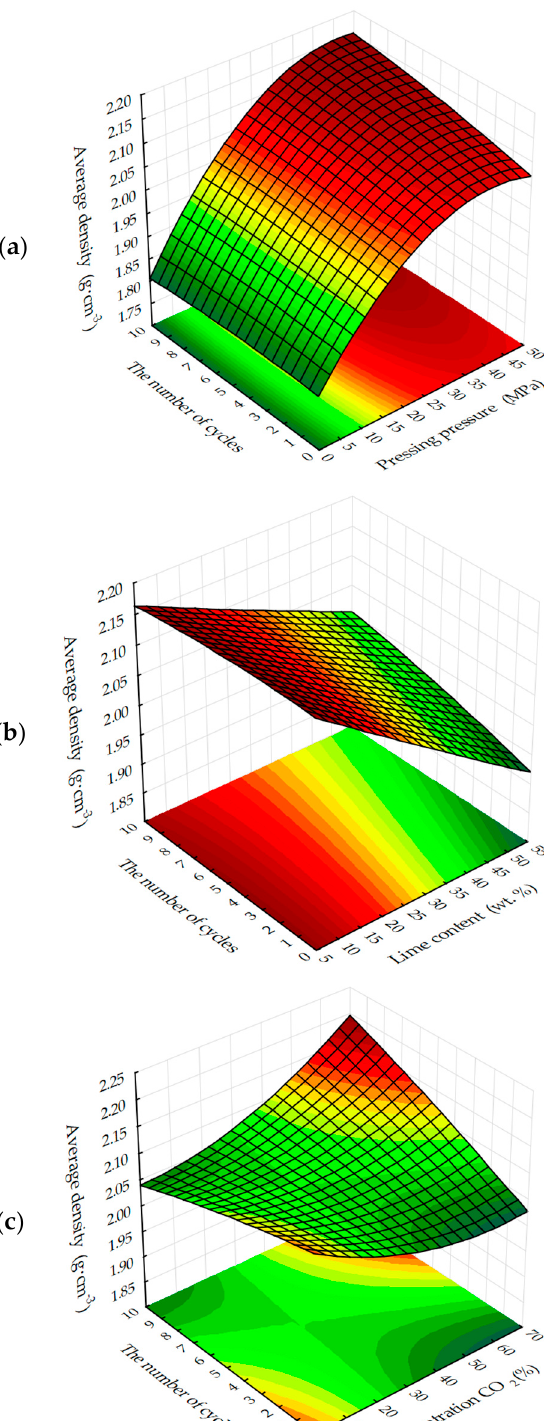
Figure 5. Response surfaces of changes in the average density of testing samples carbonated by dynamic ( 1 ) and static ( 2 ) methods, depending on: ( a ) the forming pressure of pressing and concentration of CO 2 ; ( b ) the content of lime dust and forming pressure pressing; ( c ) the content of lime dust and concentration of CO 2 (at zero level of variation of other factors).